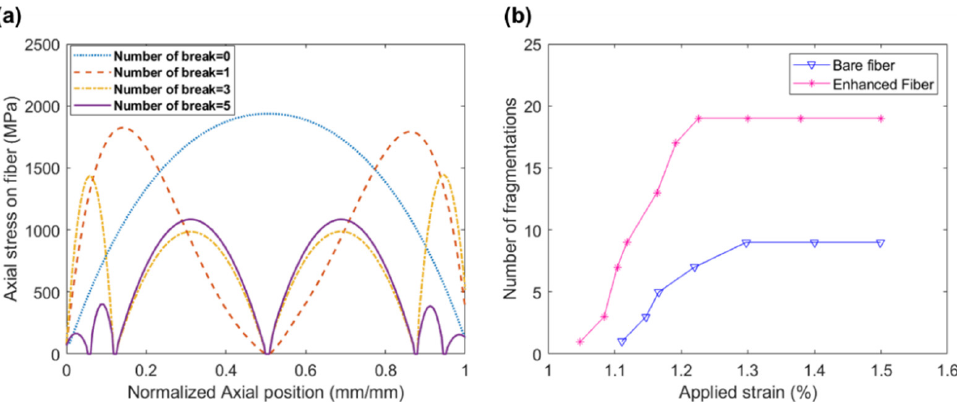
Figure 8. ( a ) Axial stress in the fiber at different fragmentation steps; ( b ) fragmentation density for bare and enhanced fiber. bare and enhanced